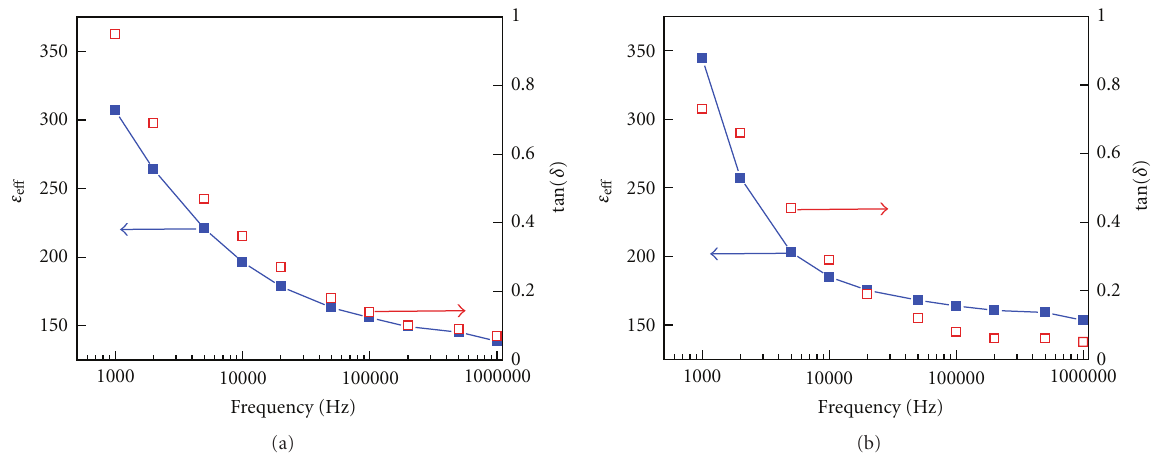
Figure 5: The dependence of dielectric constant (filled square) and loss factor (open square) on the frequency of applied ac field, from (a) the as-deposited and (b) the after-annealed BTO-MZF nanocomposite